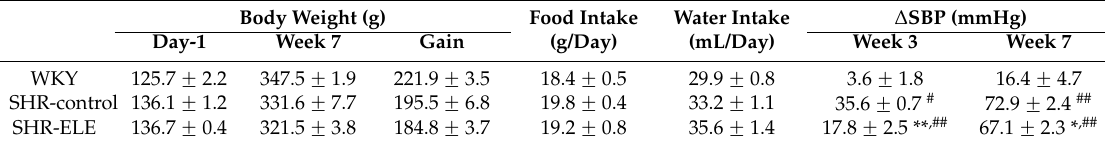
Table 1. Body weight, food and water intake, and the change in systolic blood pressure (SBP) during the seven-week study.